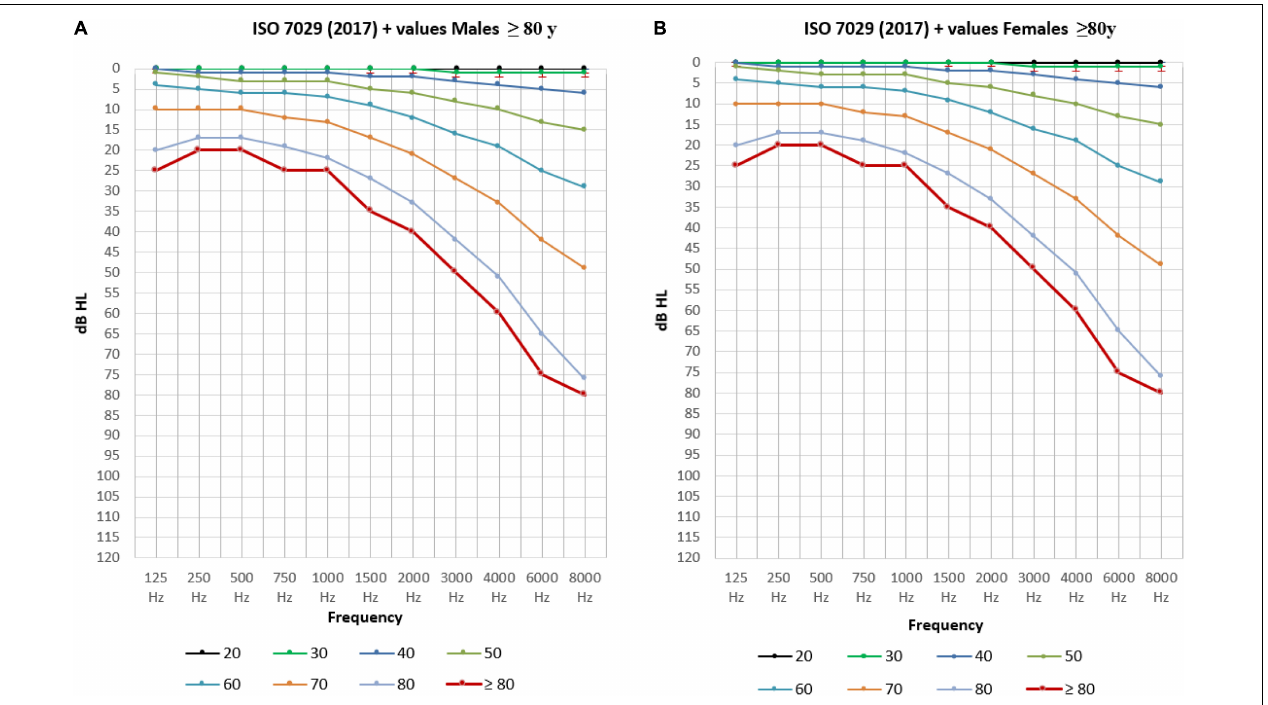
FIGURE 6 | The mean air-conduction thresholds (dB HL) in the better hearing ear for males (A) and females (B) from 18 to 80 years old according to ISO-values (Technical Committee ISO/TC 43 Acoustics, 2017) completed with the mean air-conduction threshold (dB HL) in the better hearing ear of the elderly ≥ 80 years old in the BUTTERFLY study.